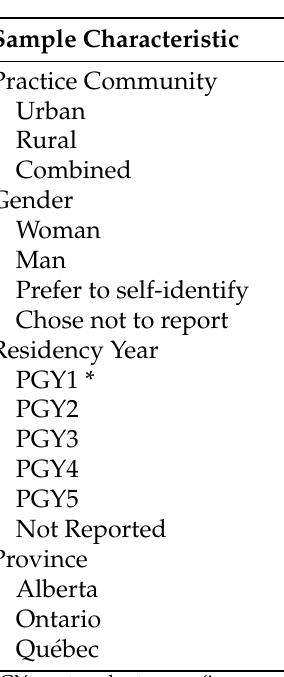
Table 2. Participants’ demographic